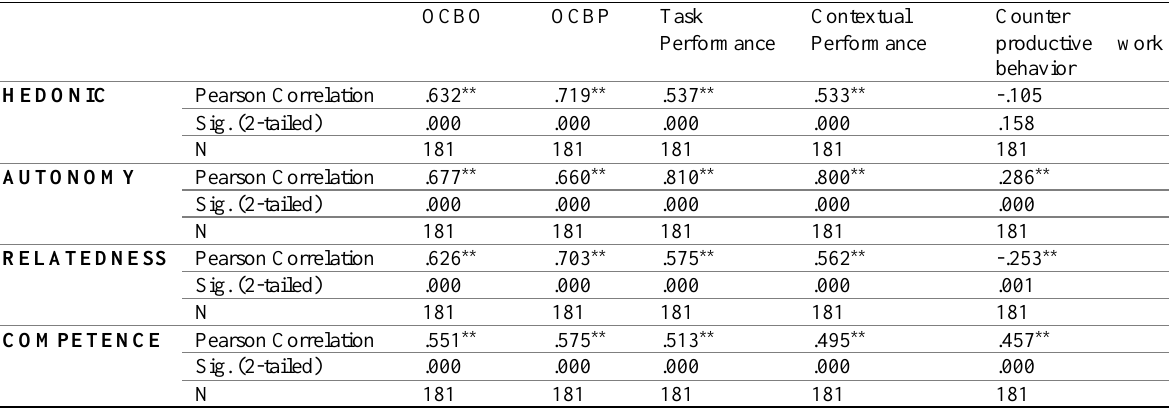
Table 8. Relationship between work environment and organizational citizenship and work performance Table 8: Relationship between Work Environment and Organizational Citizenship and work performance